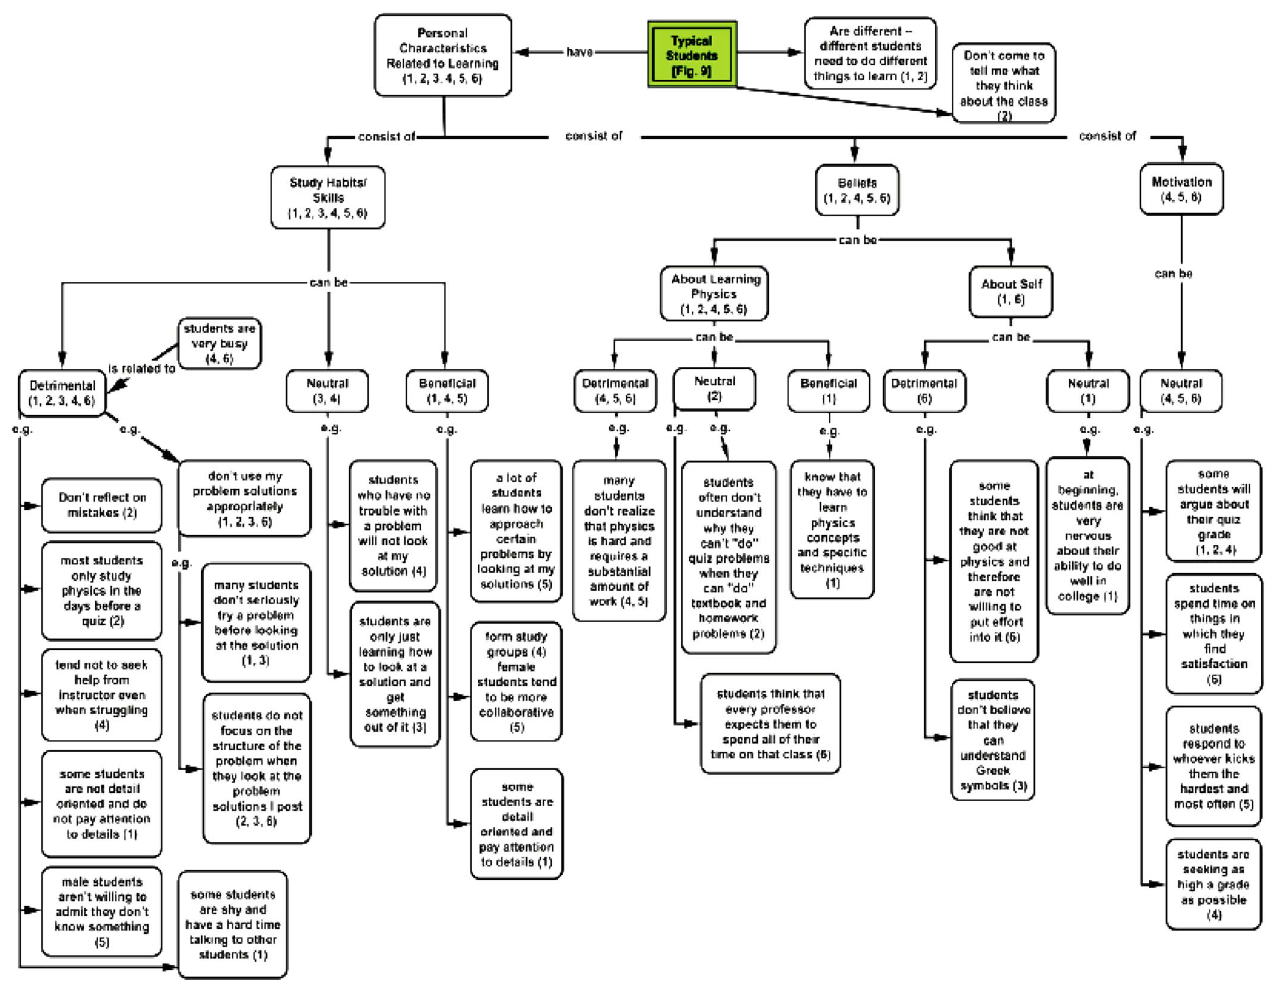
FIG. 9. (cid:1) Color (cid:2) Part of composite map “Typical Students” concerned with faculty beliefs about characteristics related to the general learning of typical students in their introductory physics course. Numbers in the parentheses denote the instructor whose statements directly justify that